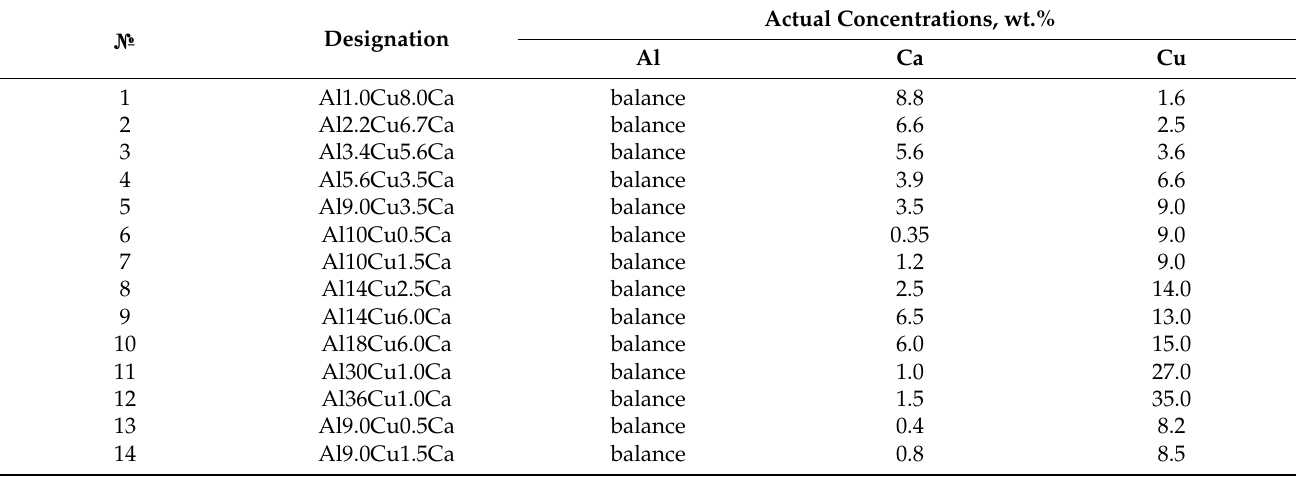
Table 1. Actual chemical composition of the experimental